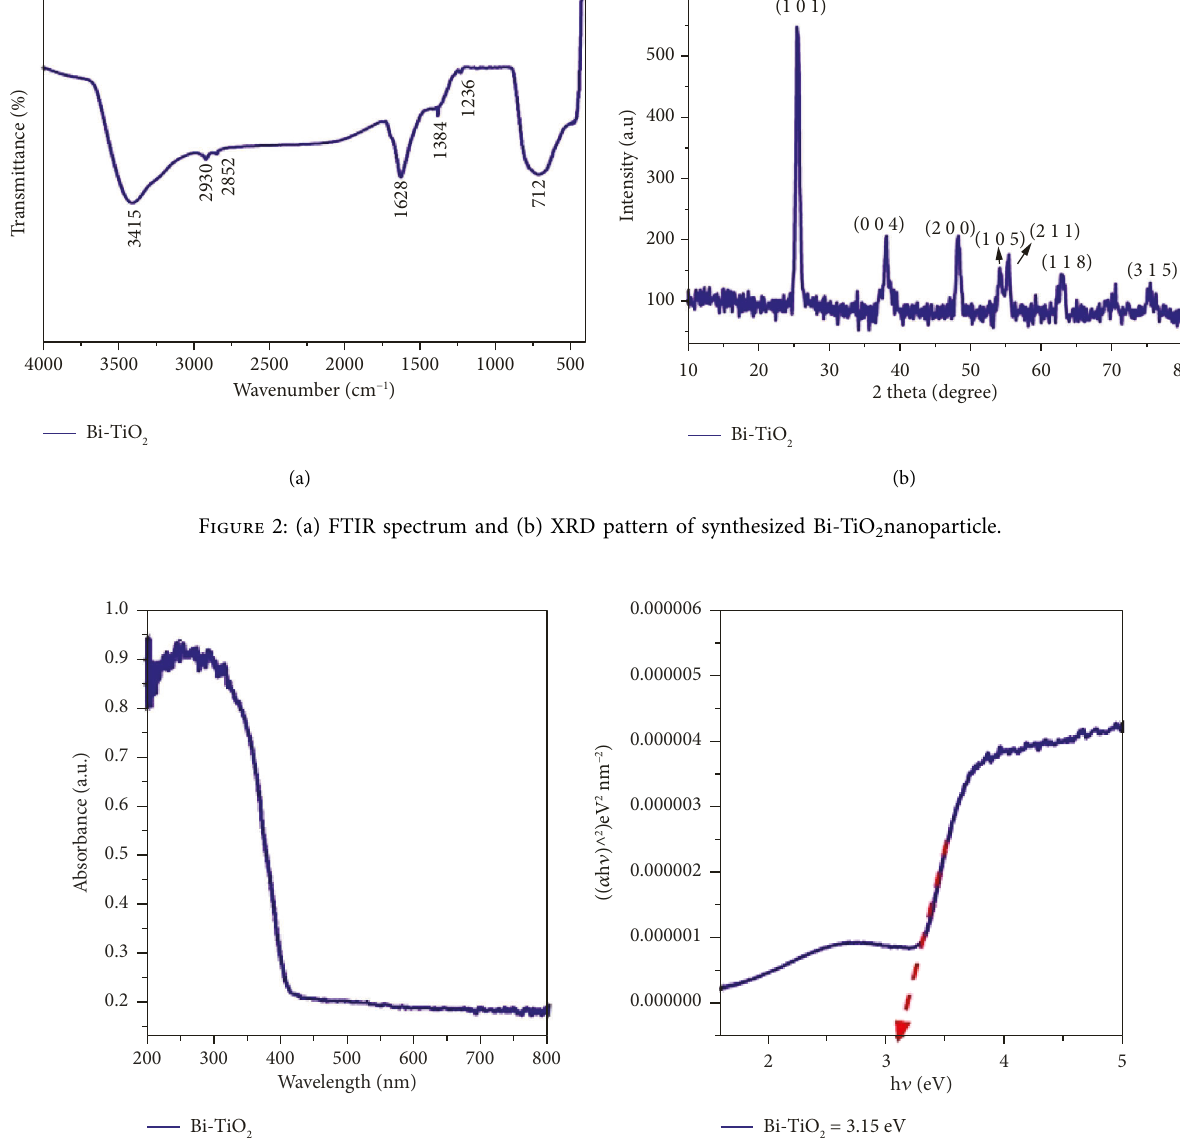
Bi-TiO 2 Figure 3: (a) UV-DRS and (b) bandgap spectrum of synthesized Bi-TiO